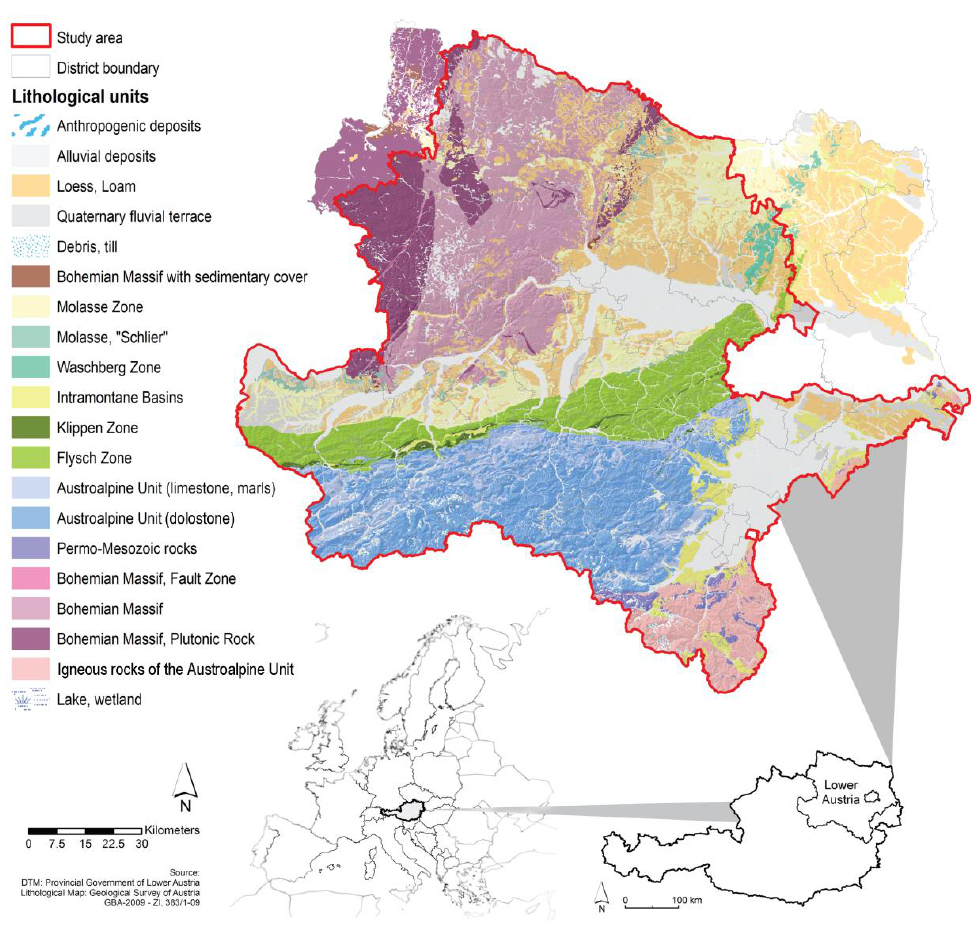
Figure 1. Location and lithology of Lower Austria. 2 Fig. 1. Location and lithology of Lower Austria.